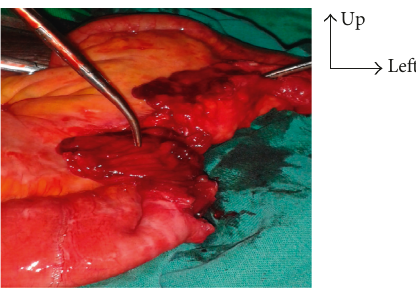
Figure 7: Exposure of the digestive fistula after median